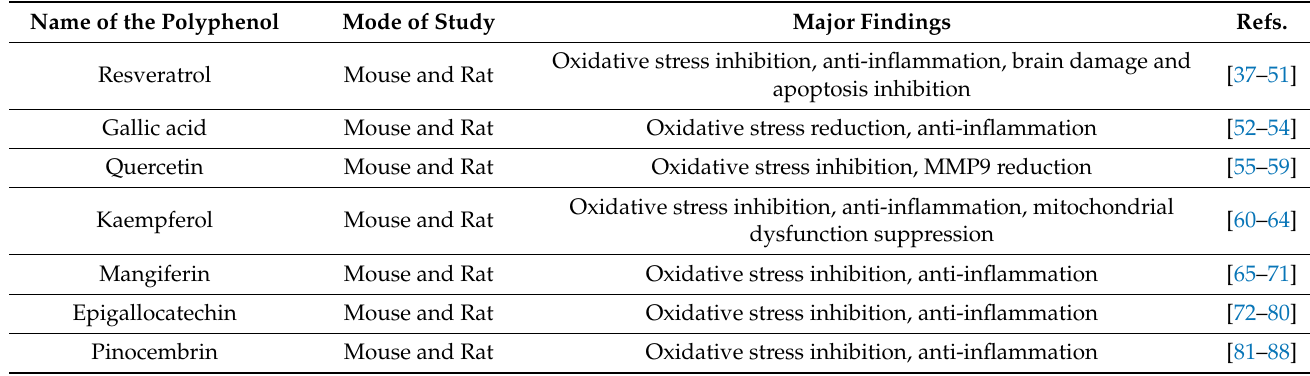
Table 1. Effects of polyphenols on stroke in animal